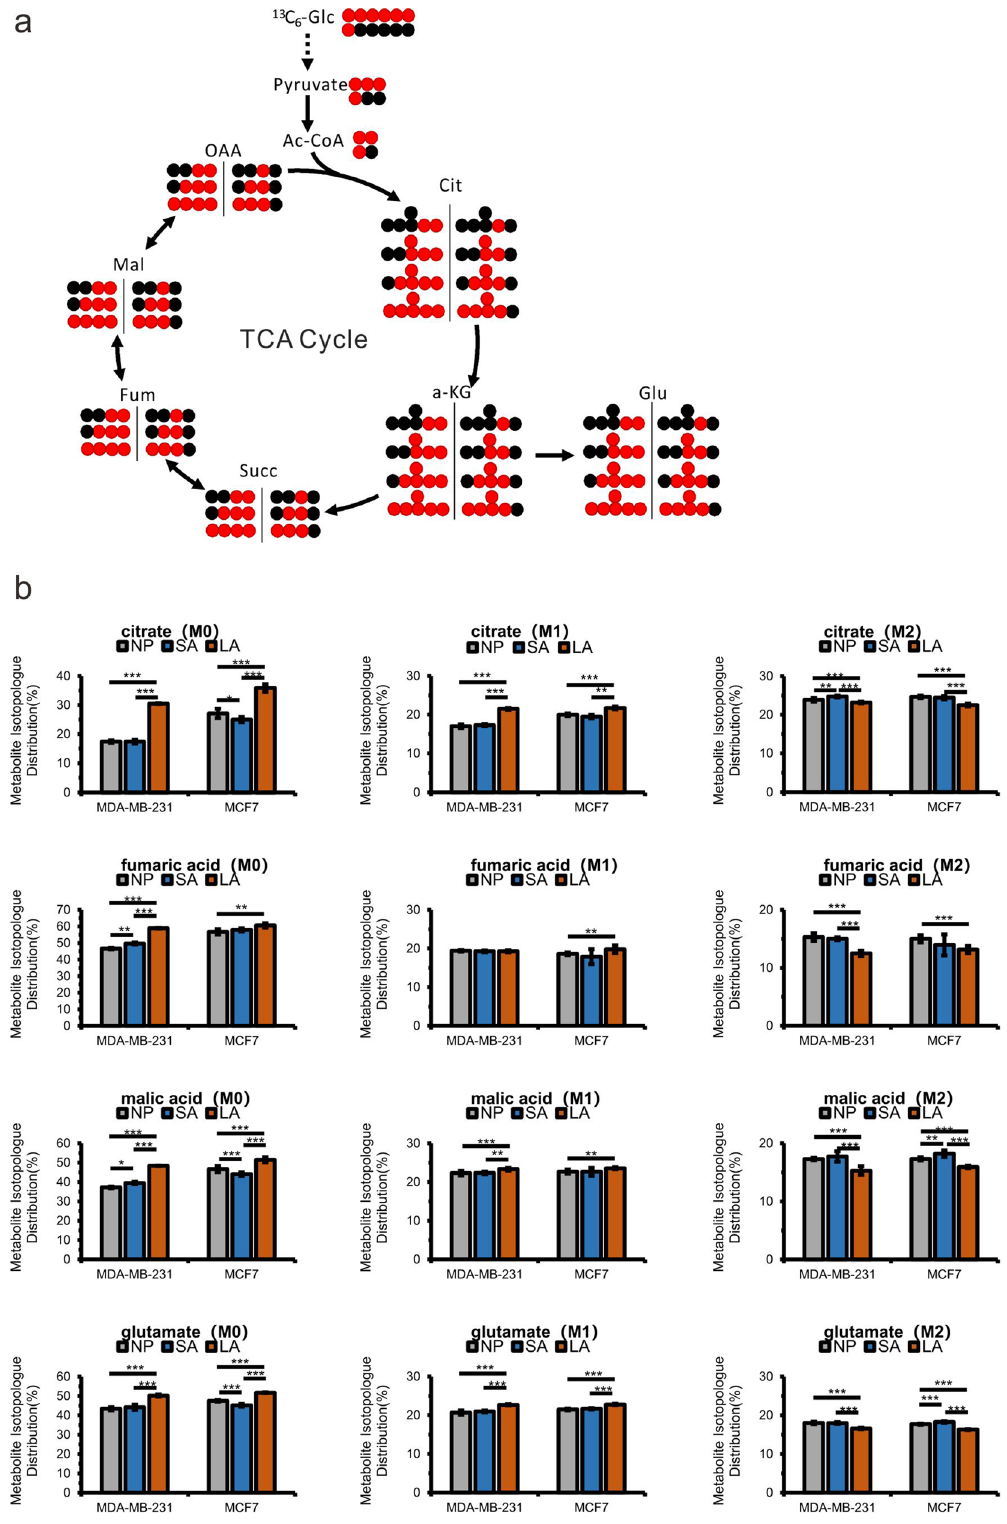
Figure 5. Changes in TCA cycle metabolism. ( a ) The labeling scheme showing 13 C atom derived from U- 13 C 6 - glucose and 1- 13 C-glucose from glucose (red dots). The black dots represent 12 C atoms. ( b ) Comparisons of mass isotopologue distributions (MIDs) of citrate, fumaric acid, malic acid and glutamate of MDA-MB-231 and MCF-7